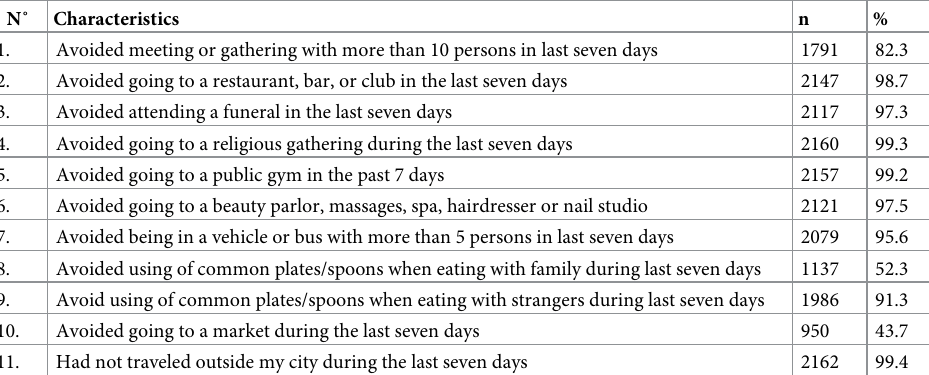
Table 4. Adherence to community preventive measures for